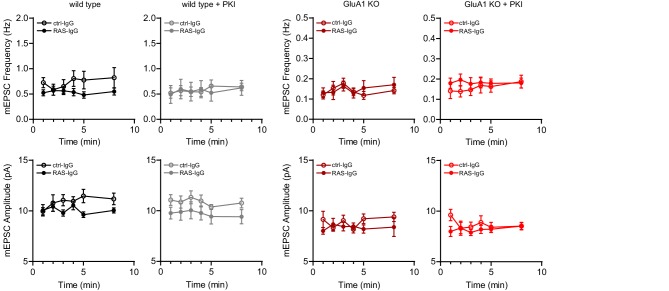
The infusion of anti-Ras IgG or control IgG did not affect basal mEPSC frequency or amplitude.Recordings as shown in Figure 6 were made in acute slices from WT (IgG: n=7; RasIgG: n=9; IgG/PKI: n=9; RasIgG/PKI: n=7) or GluA1-KO mice (IgG: n=11; RasIgG: n=11; IgG/PKI: n=8; RasIgG/PKI: n=12) in the presence or absence of PKI and with the infusion of anti-Ras IgG or control IgG in the internal solution. Miniature EPSC recordings were started immediately after achieving whole-cell configuration and the average mEPSC frequency and amplitude were determined per minute. No significant changes over time were detected in both frequency and amplitude (RM-ANOVA, WT freq: p=0.09, ampl: p=0.6; WT/PKI freq: p=0.04, all post hoc p>0.05, ampl: p=0.4; GluA1-KO freq: p=0.1, ampl: p=0.9; GluA1-KO/PKI freq: p=0.5, ampl: p=0.3).